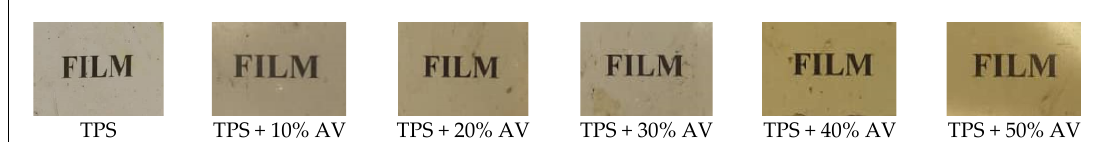
Figure 6. The physical appearance of TPS film with different AV gel